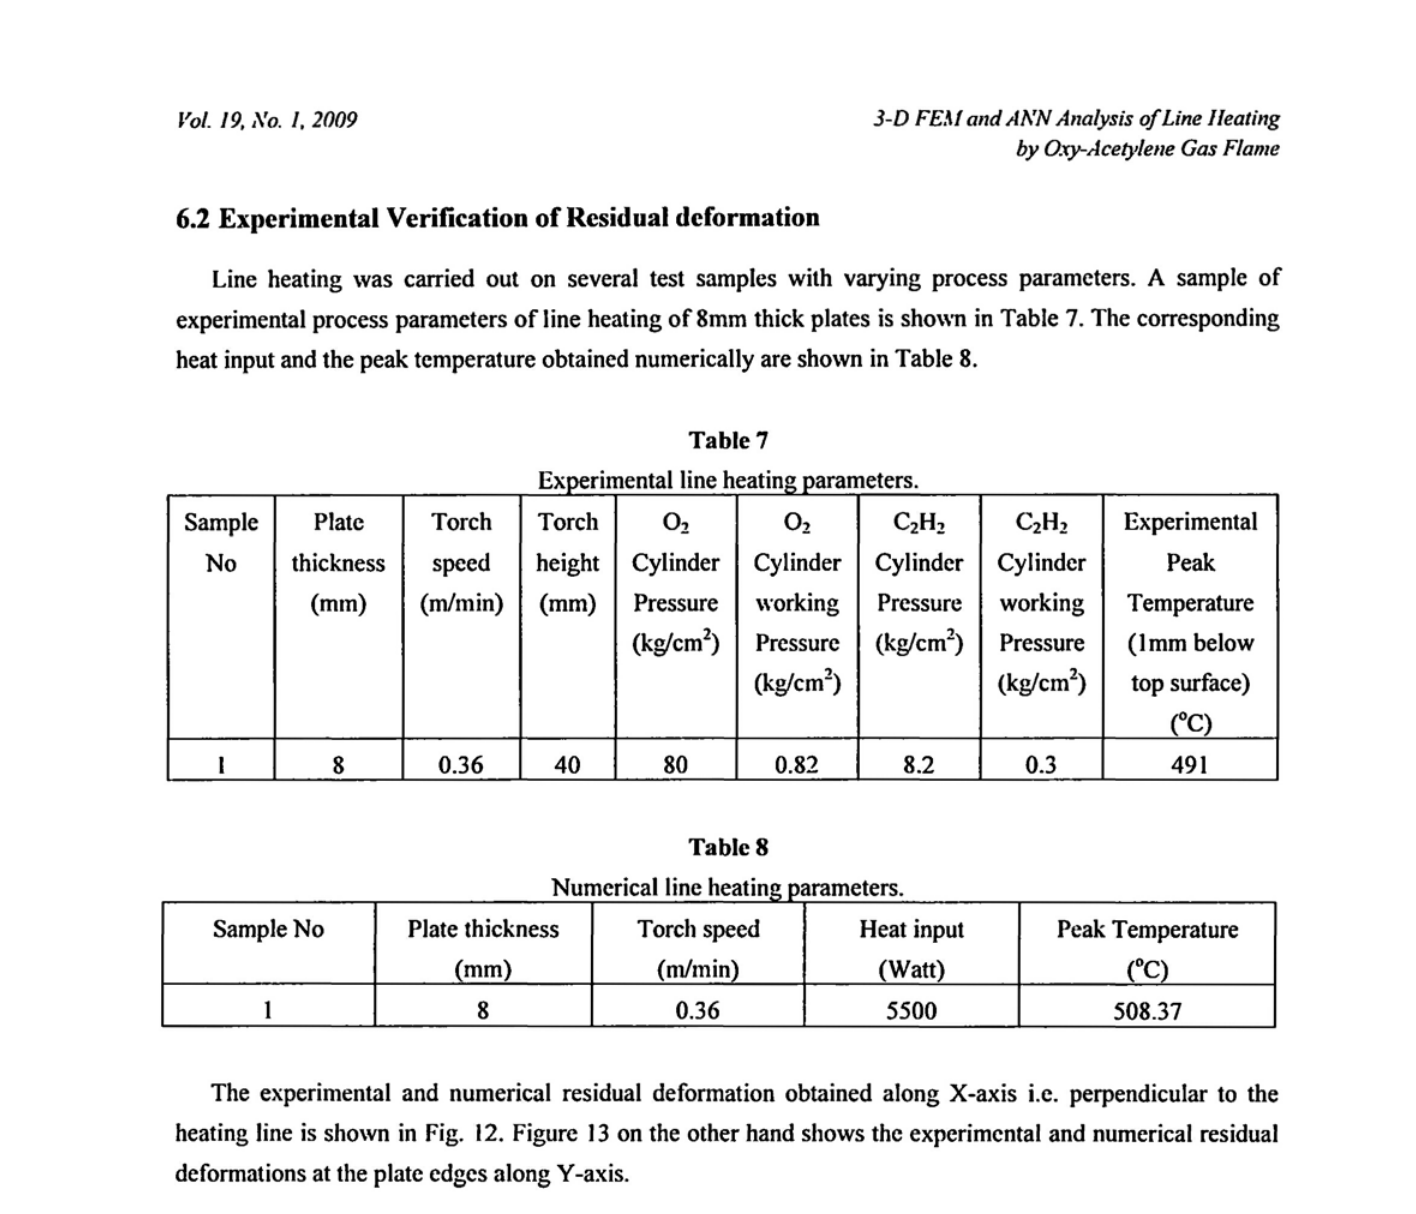
Numerical line heating parameters.